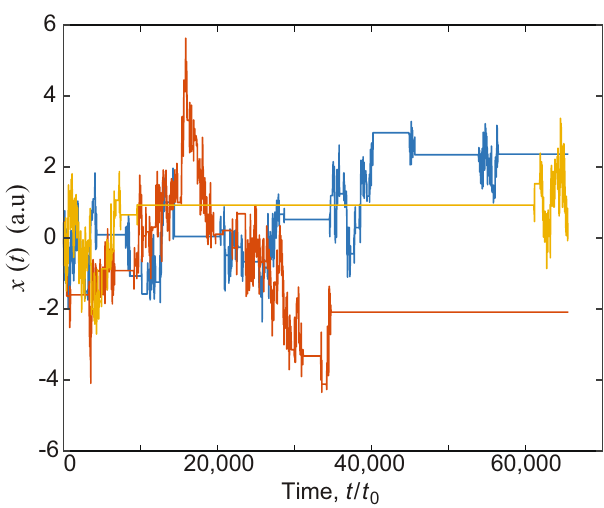
Fig. 1 Representative trajectories for a subordination fractional Brownian motion process. The Hurst exponent in these trajectories is H = 0.3 and the CTRW anomalous exponent is α = 0.8. Long immobilization times are observed within the fractional Brownian